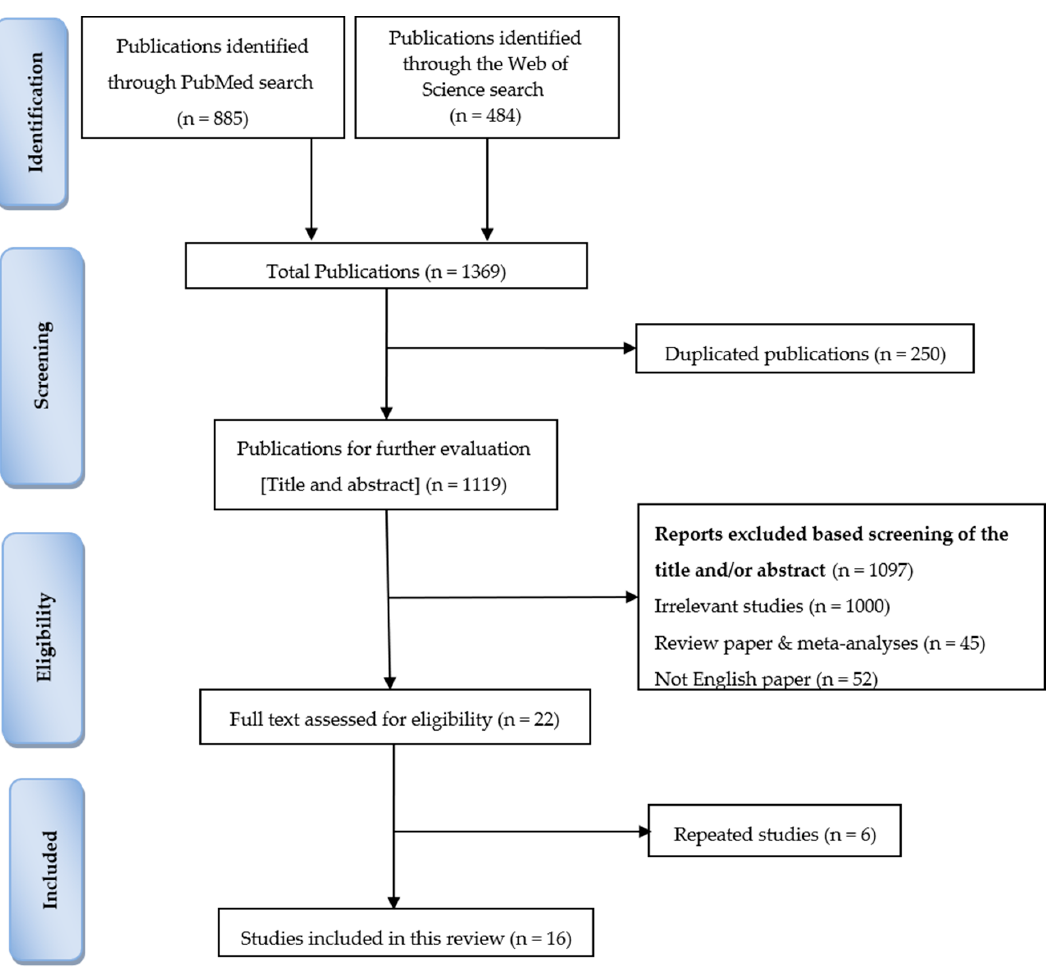
Figure 1. Summary of the search strategy based on the preferred reporting items for systematic reviews and meta-analyses (PRISMA) statement guidelines.